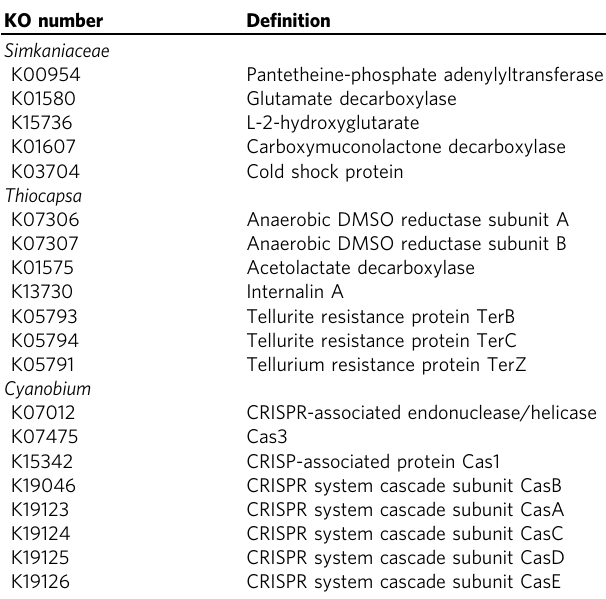
Table 1 KEGG orthologues that are present in the novel MAGs but absent in their sister